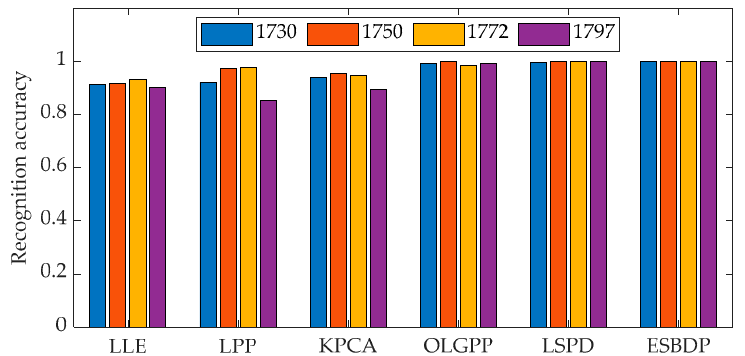
Figure 10. Recognition accuracy at different speeds.